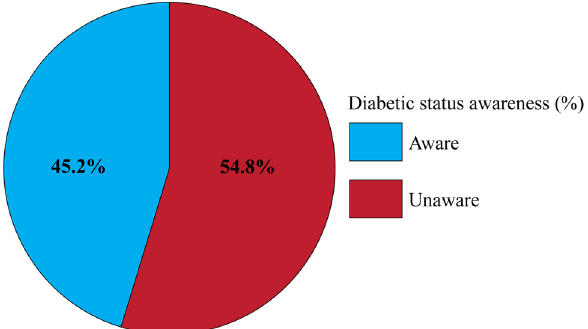
Figure 5. Undiagnosed diabetics among rural residents over 20 years old in Nièna municipality. Among T2D participants, 54.8% (17/31) of subjects that tested positive for diabetes were unaware of their diabetic status.